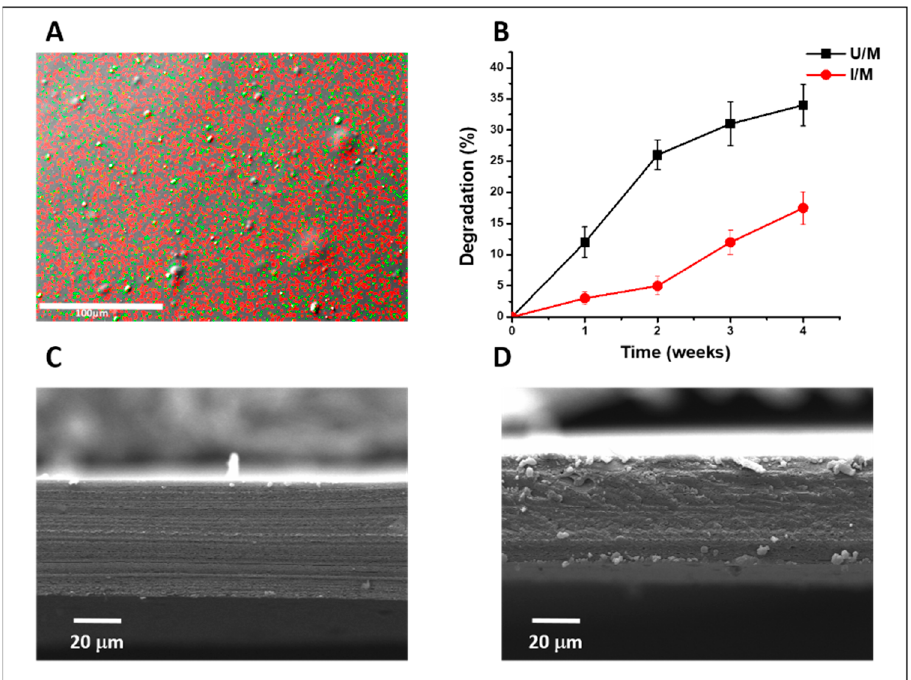
Figure 1. Membranes characterizations. ( A ) Distribution of nanoparticles in gelatin/chitosan mem- brane by SEM/EDS analysis, calcium (green dots) and titanium (red dots). ( B ) enzymatic degradation assay. ( C , D ) cross-section membrane microstructure, SEM microphotographs. U/M: membrane non-UV-irradiated, I/M: membranes UV-irradiated.